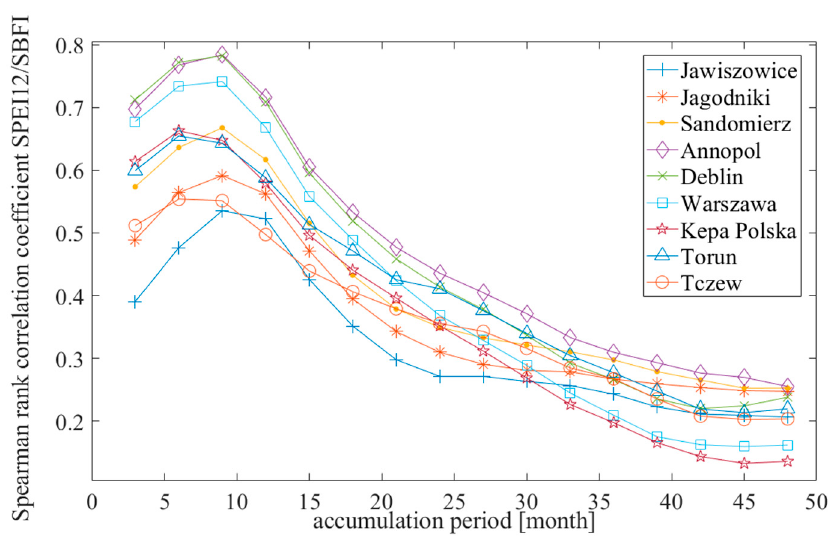
Figure 15. Spearman rank correlation coefficient between SPEI12 and SBFI as a function of the SBFI accumulation time for nine sub-catchments along the Vistula River.